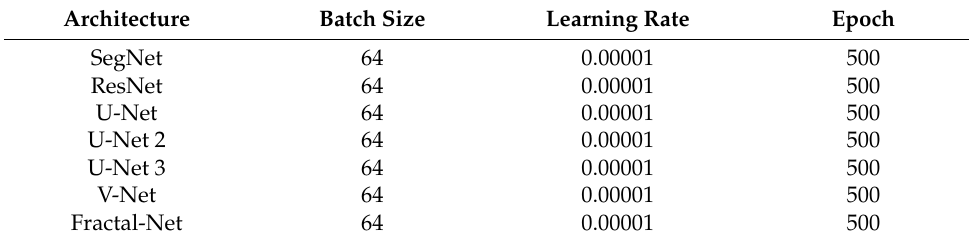
Table 3. Parameters for the various CNN Architectures.